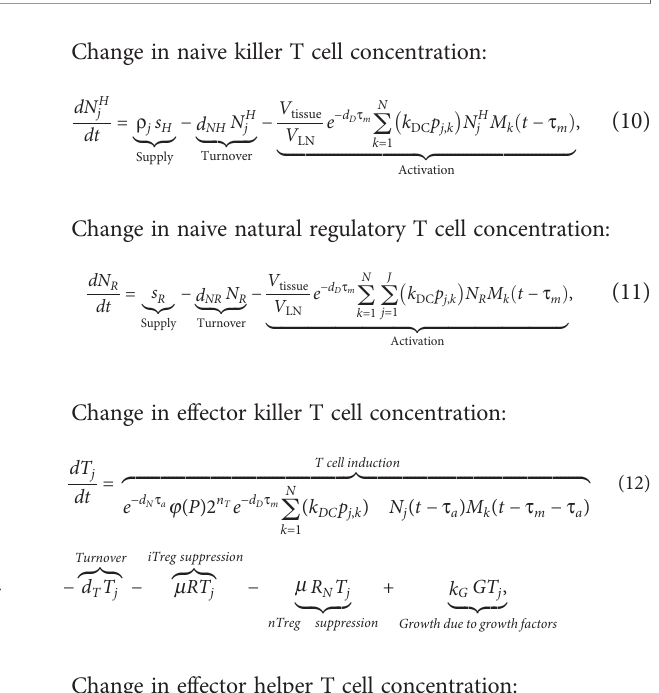
FIGURE 1 | Block diagram depicting key aspects of our theoretical vaccination model. An injection of peptide vaccine is given intramuscularly with adjuvant. Immature DCs are injected intranodally, prompting an accumulation of antigen by maturing DCs. These maturing DCs then migrate and activate naive T cells in the lymph node, which then proliferate into effector T cells. Effector T cells can both strip peptides off the surface of cancer cells via trogocytosis and kill